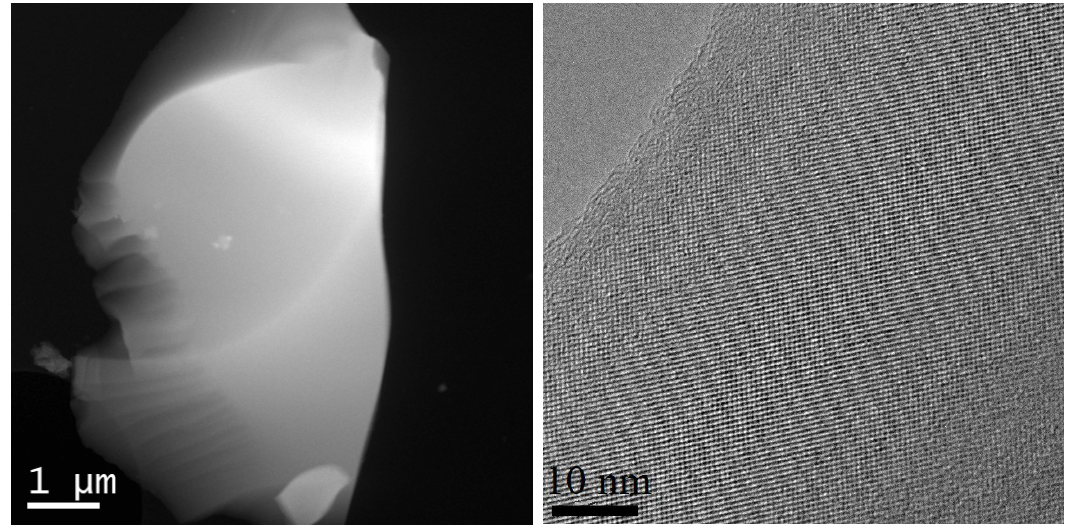
Figure 3. Morphology and microstructure of particles on the example of a sample C12A7:e − .